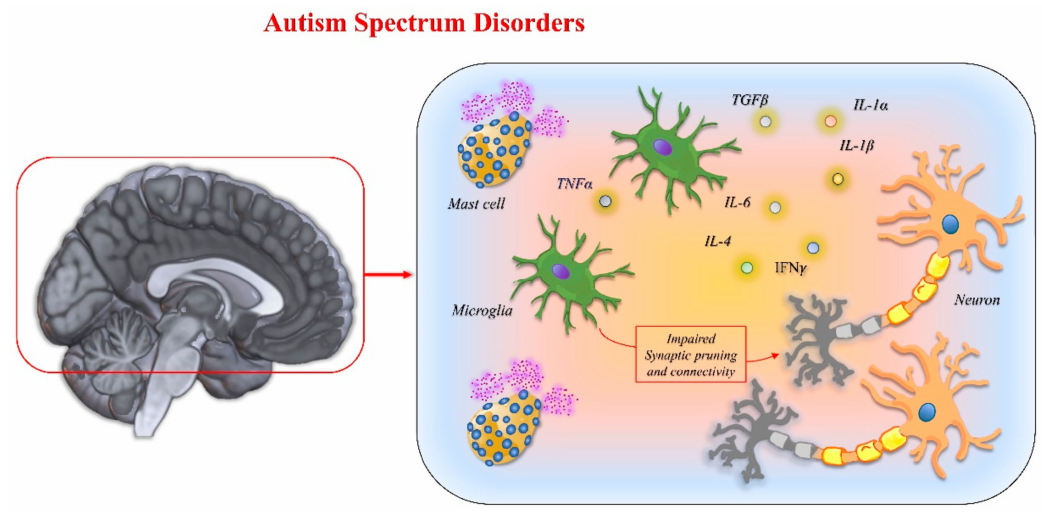
Figure 9. The main immunological mechanisms associated with autism spectrum